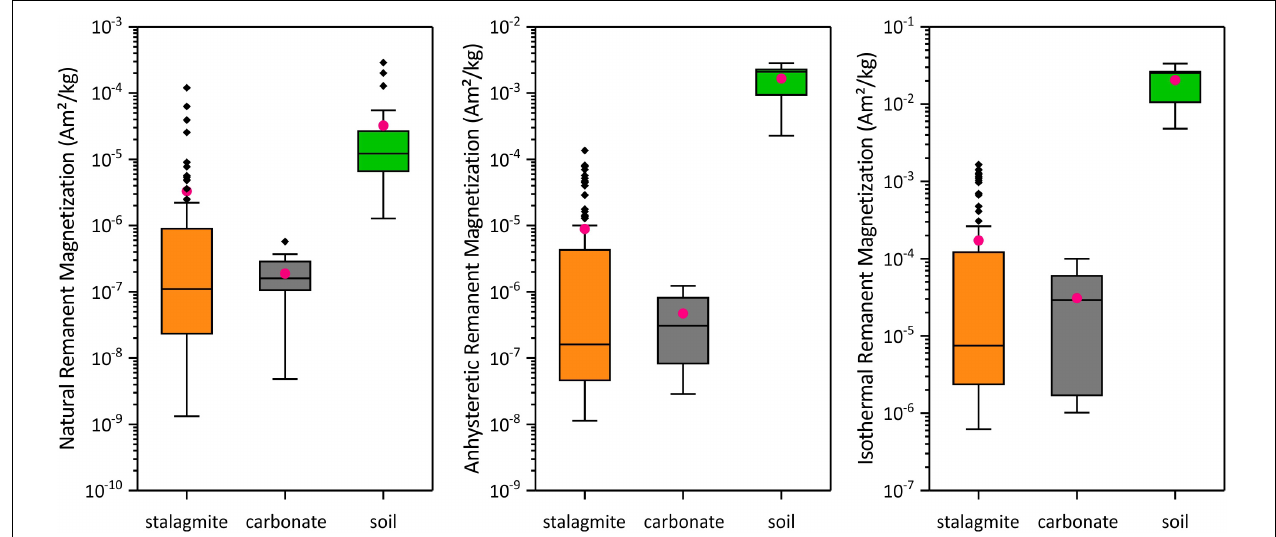
FIGURE 4 | Box plot of remanent magnetization of stalagmites (orange), carbonates (gray), and soil (green), for natural remanent magnetization (NRM), anhysteretic remanent magnetization (ARM), and isothermal remanent magnetization (IRM).